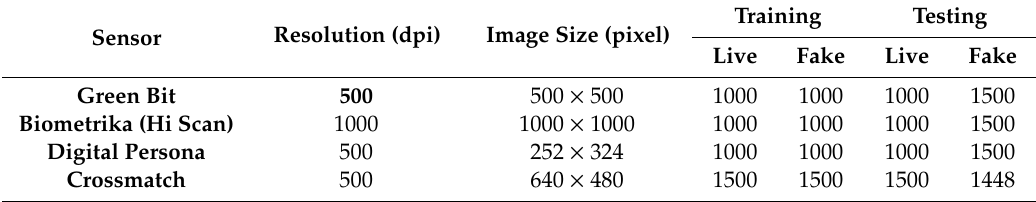
Table 1. Device and image characteristics of the LivDet 2015 dataset.